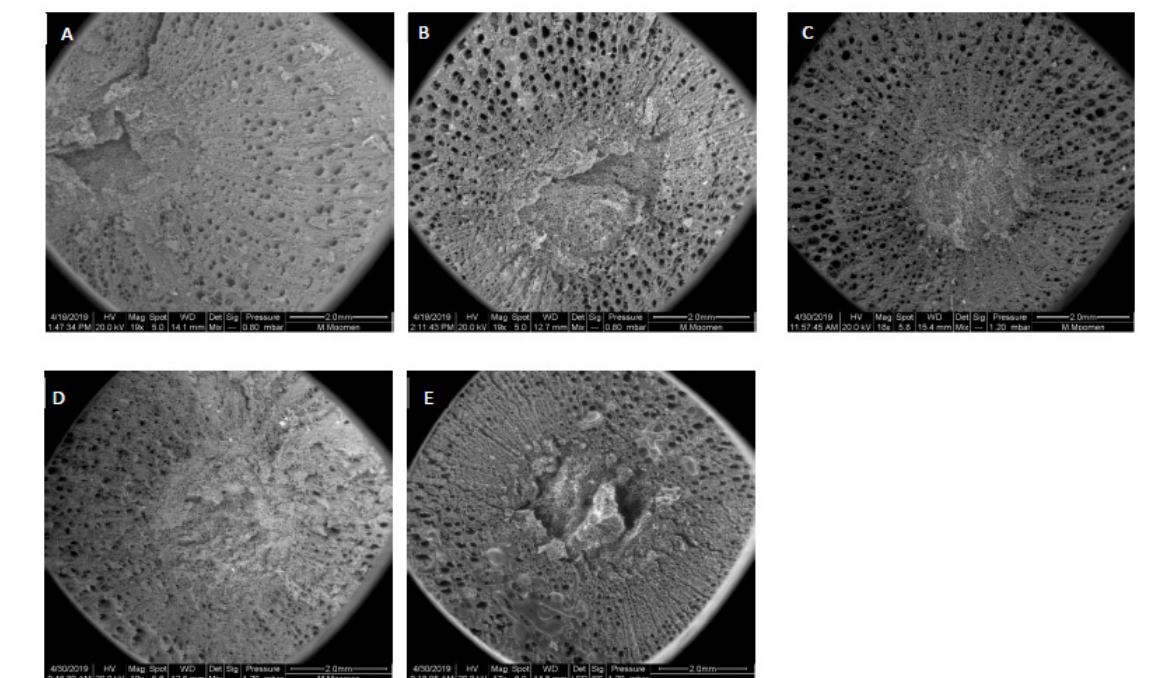
Figure 3. General view and comparison of freshly stem cross sections visualized by Environmental Scanning Electron Microscopy corresponding to five local and rain-fed grapevine ( A ): Hencha, ( B )